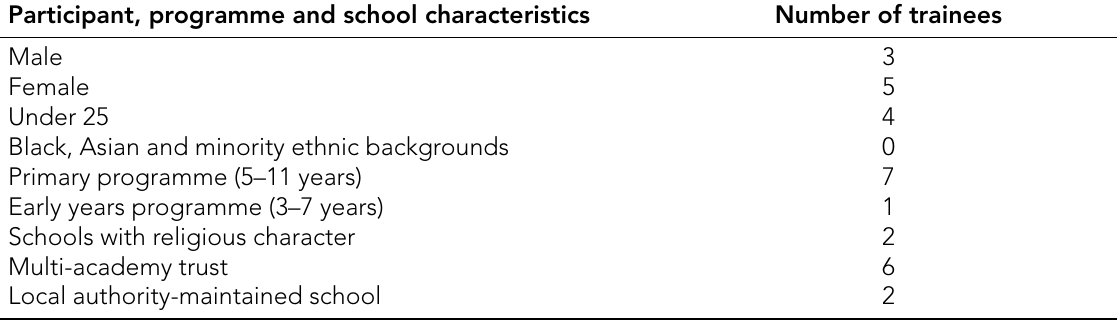
Table 1. Characteristics of participant sample (Source: Author,